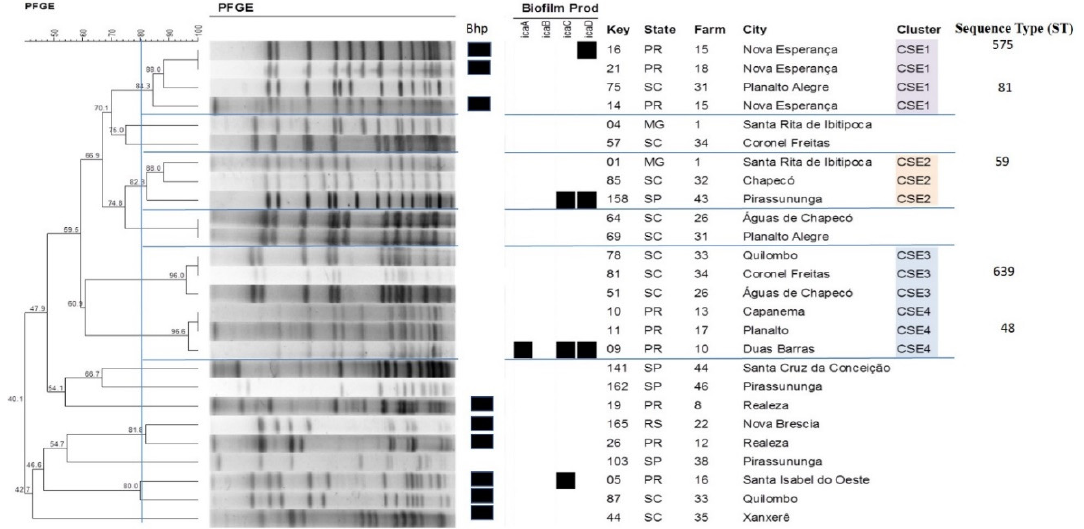
Figure 4. Dendrogram generated from the PFGE pattern of Staphylococcus epidermidis isolates (Dice similarity coefficient; clustering method: UPGMA).